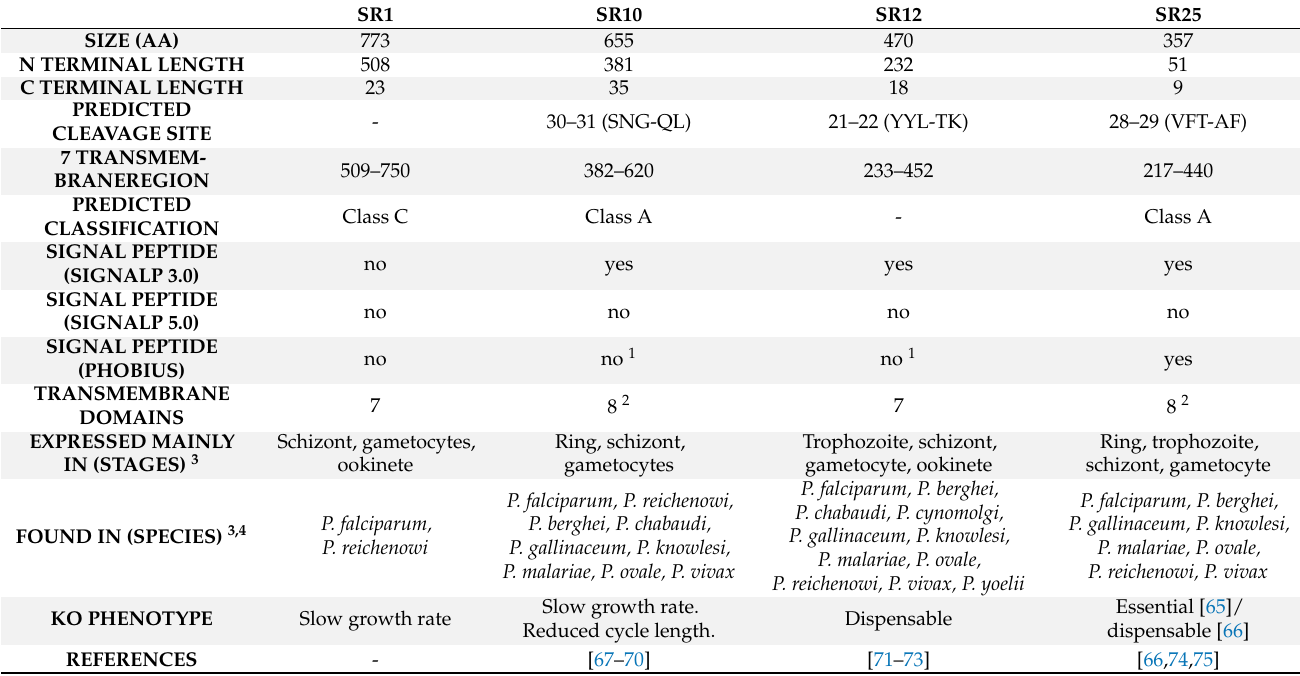
Table 2. Characteristics of GPCR-like proteins found in Plasmodium